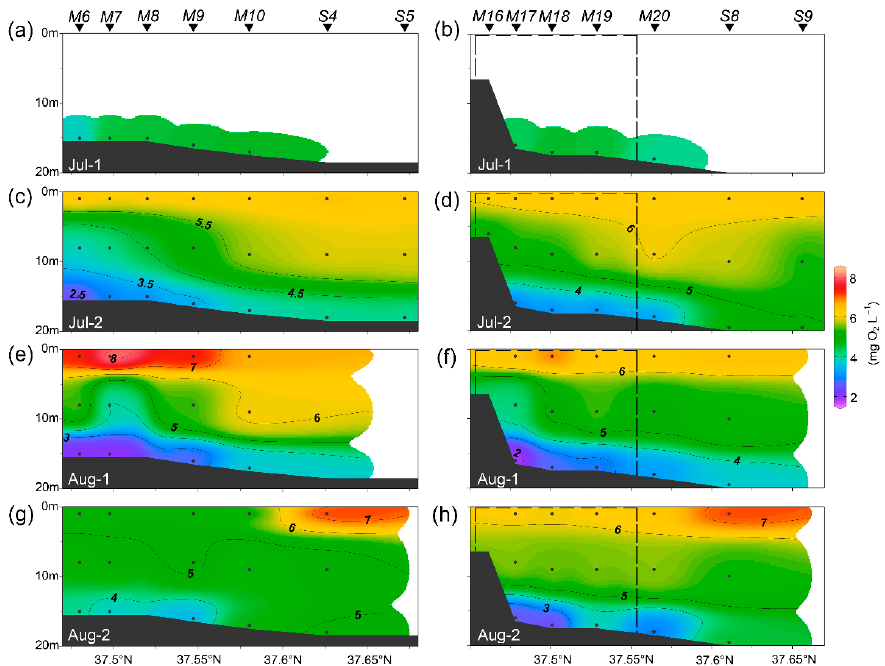
Figure 2. Vertical profiles of dissolved oxygen along Transects 1 (left panel, ( a , c , e , g )) and 2 (right panel, ( b , d , f , h )) during four cruises in the middle (Jun-1, ( a , b )) and late July (Jul-2, ( c , d )), and early (Aug-1, ( e , f )) and late August (Aug-2, ( g , h )) of 2015. Triangles along the uppermost margins indicate the positions of sampling stations. The dashed boxes refer to the location of ranching zone ( b , d , f , h ).